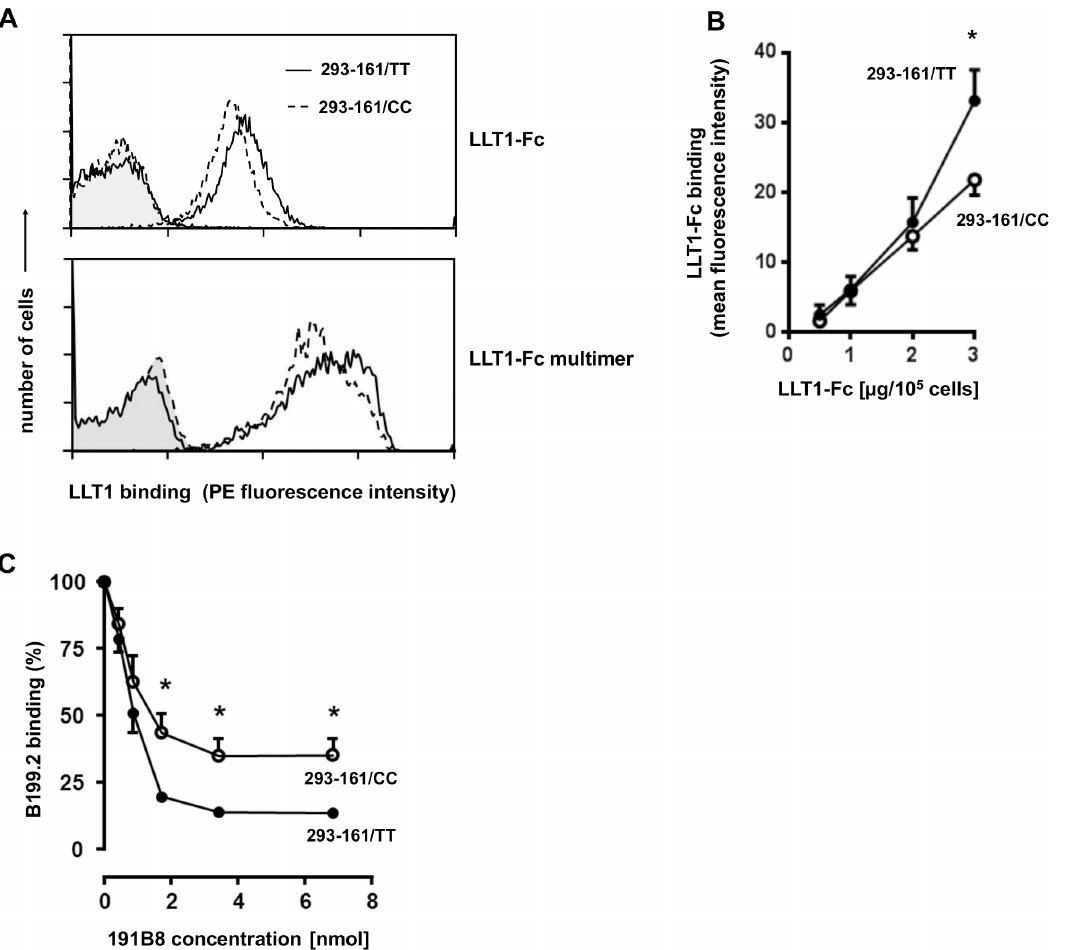
Fig 3. Characterization of the ligand-binding domain of CD161/TT and CD161/CC receptors. (A) Fluorescence histograms obtained after incubation of 293-CD161/TT and -CD161/CC transfectants with control Ig-Fc (closed histograms) and LLT1-Fc or LLT1-Fc proteins multimerized by protein A (open histograms). Binding of the recombinant protein to CD161 was demonstrated by PE-conjugated goat anti-human IgG. (B) Dose-effect relationship of LLT1-Fc binding. 293-CD161/TT and -CD161/CC cells were incubated with increasing amounts of LLT1-Fc. Mean fluorescence intensity (MFI) was determined after a second incubation step with PE-conjugated goat anti-human IgG. Results represent mean values ± SEM calculated for three independent experiments; * p < 0.05 (Unpaired t-test). (C) Epitope-specific antibody competition in CD161/TT and -CC receptor variants. 293-CD161/TT and -CC cells were incubated with a fixed concentration (10 μ g/ml) of PE-labelled anti-CD161 mAb B199.2 alone and in combination with increasing amounts of competing anti-CD161 mAb 191B8 (IgG2a) or the anti-pig MHC class-II mAb MSA3 as IgG2a isotype control. Samples were analysed by flow cytometry and PE-MFI was determined. Competition is shown as % binding of mAb B199.2 and was calculated as follows: MFI (B199.2 plus 191B8) / MFI (B199.2 plus MSA3) x 100. MFI obtained with B199.2 in the absence of competing antibody was set as 100%. Results represent mean values ± SD calculated for five independent experiments; * p < 0.05 (Unpaired